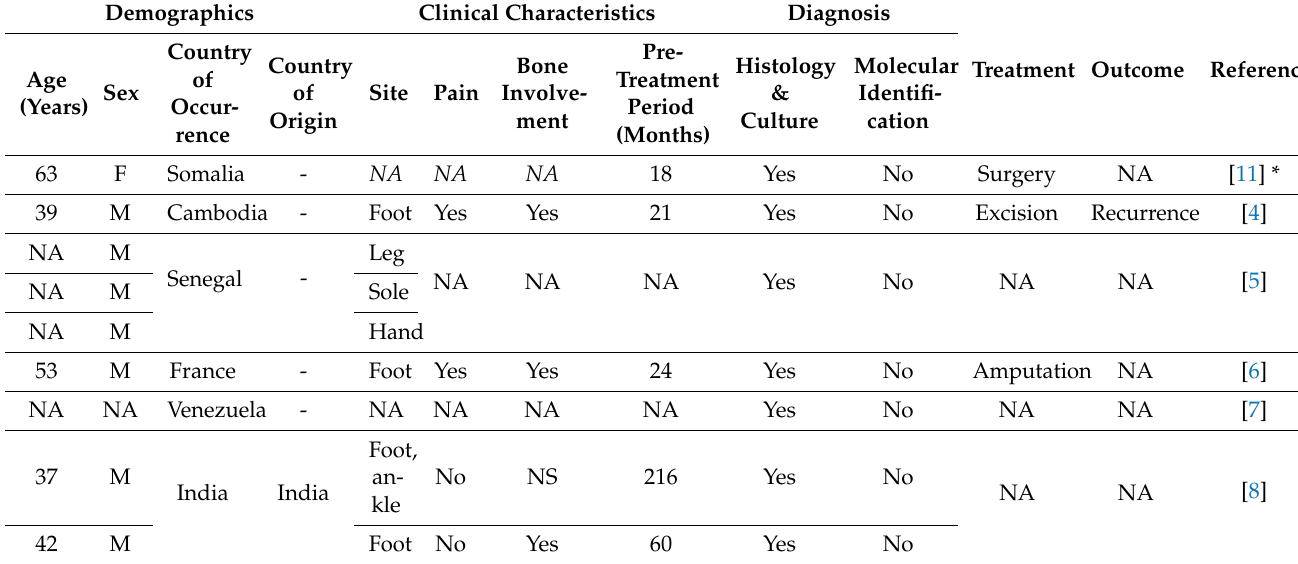
Table 1. Demographics, clinical characteristics, and treatment outcomes of the patients with M. romeroi eumycetoma cases in the literature.